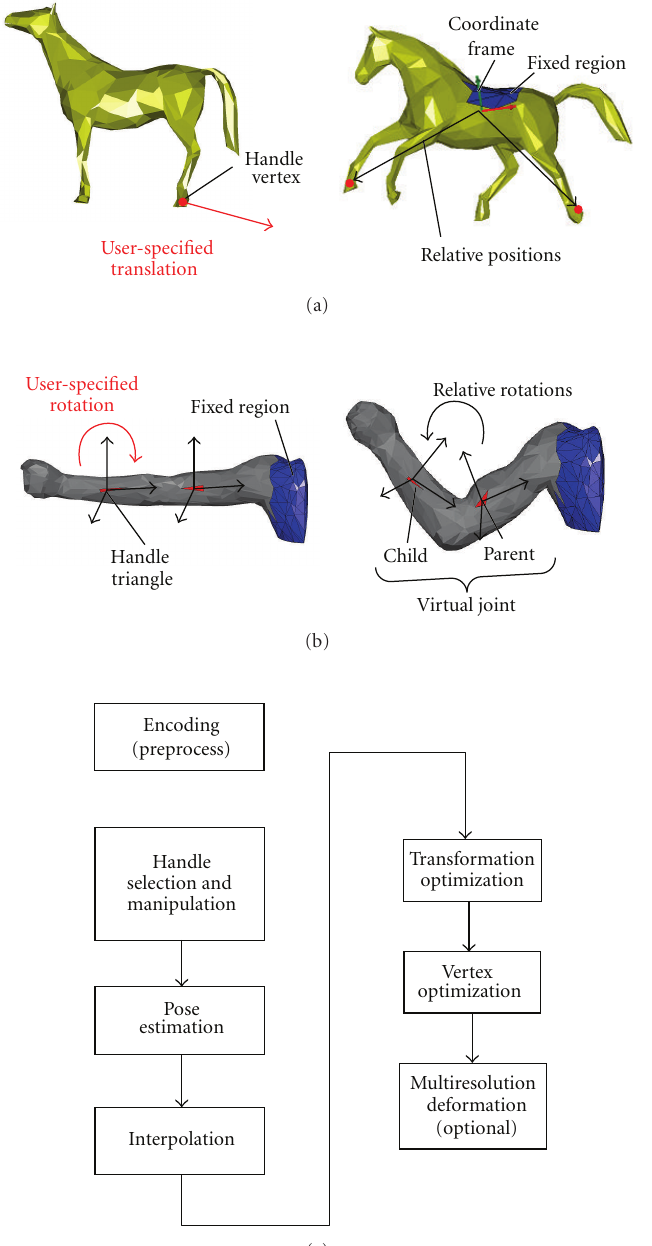
Figure 1: Overview of our method. (a) Global pose editing is achieved with the translational control. (b) Local pose editing is done using the rotational control. (c) Flow of